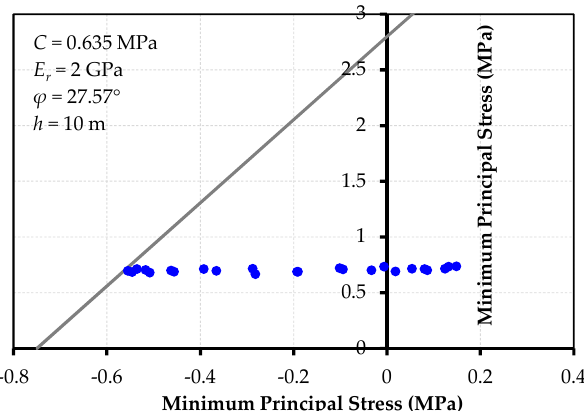
Figure 7. The principal stresses in elements surrounding the tunnel, and their locations relative to the critical line.